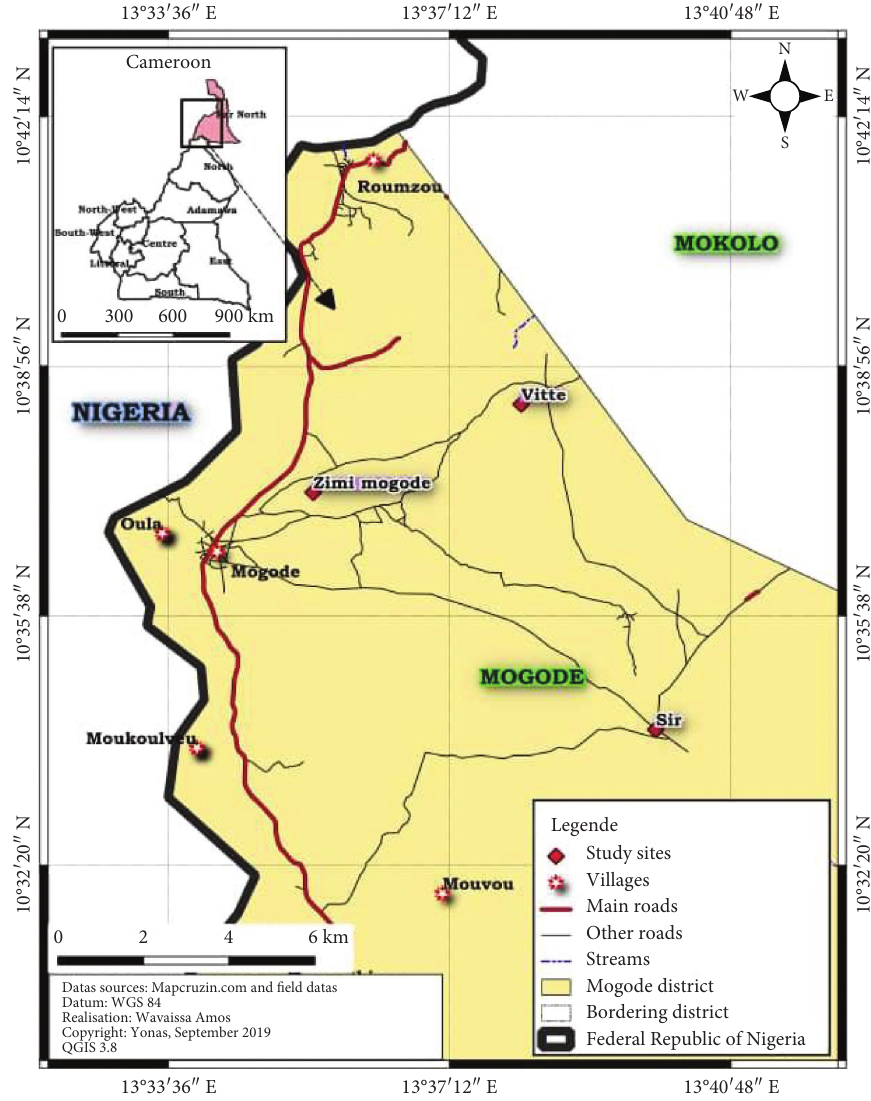
Figure 1: Map of the survey and sampling sites. Table 1: Factors influencing the processing of the indigenous “T´ea L´emi”